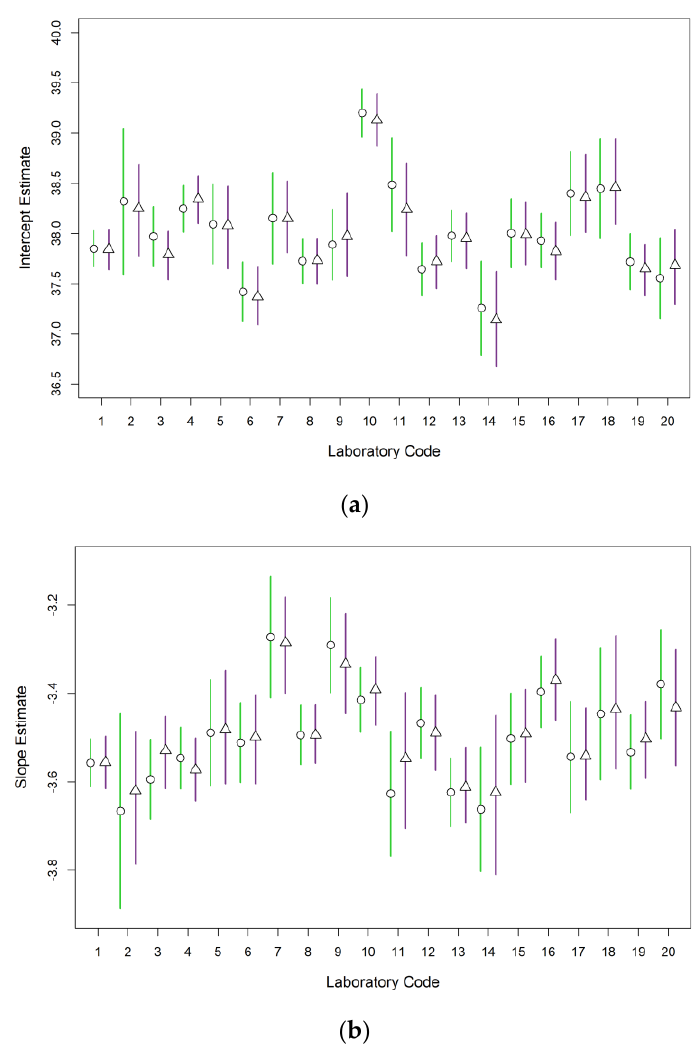
Figure 1. Weighted Linear Regression (WLR) and Master Standard Curve (MSC) mean intercept and slope estimates. Comparison of ( a ) mean intercept and ( b ) slope estimates of the 2016 standard curve composite WLR (green bar with open circle) and Bayesian MSC (purple bar with open triangles) models. Open circles and triangles on bars indicate the mean least-squares and Bayesian intercept and slope estimates, respectively. Vertical lines represent the WLR 95% CI (green) and Bayesian MSC 95% BCI (purple).